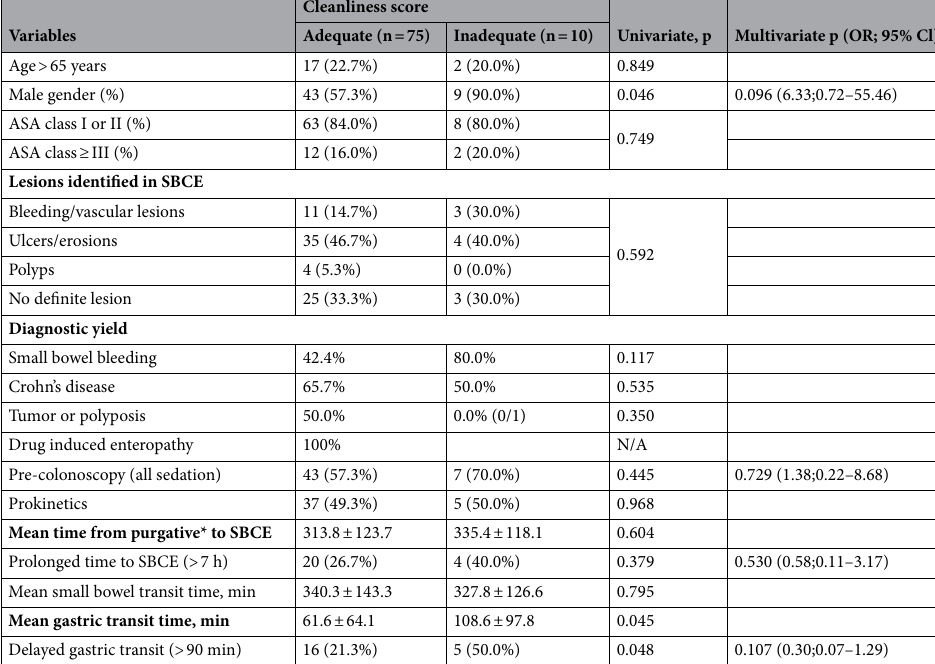
Table 3. Univariate and multivariate analysis of adequate cleansing cases (N = 85). ASA American Society of Anesthesiologists, SD standard deviation. *Last dose of purgative.